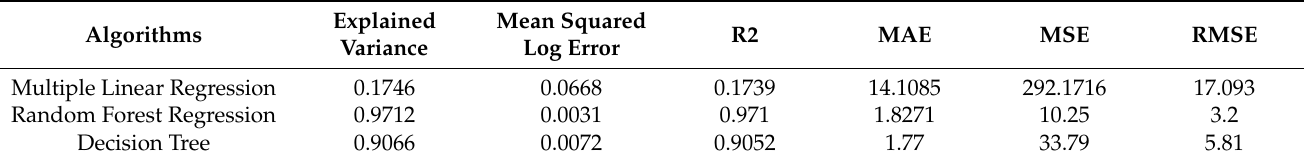
Table 10. Comparison of Regressors